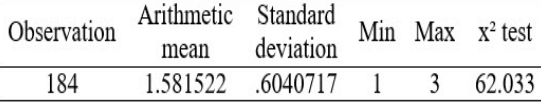
Table 2. Results of statistical analysis of